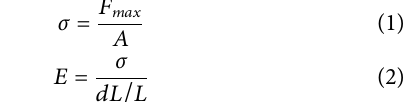
Frontiers in Materials |